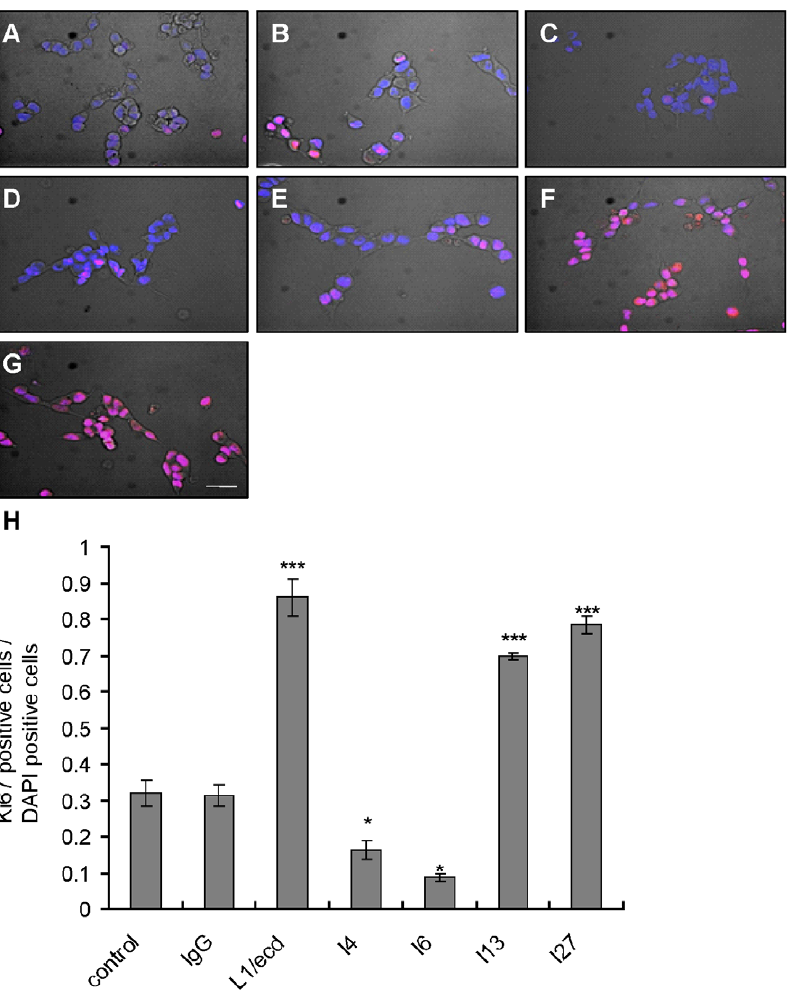
Figure 4. ScFvs against Ig1–4 inhibit, while scFvs against Fn1–3 increase proliferation of SK-N-SH cells. Representative images are merged with bright field, DAPI (blue) nuclear staining, and Ki67 immunostaining (red). ( A ) Control without treatment, ( B ) negative control with non- immune human IgG (10 m M), ( C ) scFv I4, ( D ) scFv I6, ( E ) scFv I13, ( F ) scFv I27, ( G ) positive control with L1/ecd (all at 16.5 m M). Scale bar in ( E ) indicates 20 m m (for all panels). ( H ) Mean values 6 SEM of the ratio of Ki67-immunopositive cells to DAPI-positive cells are shown from three